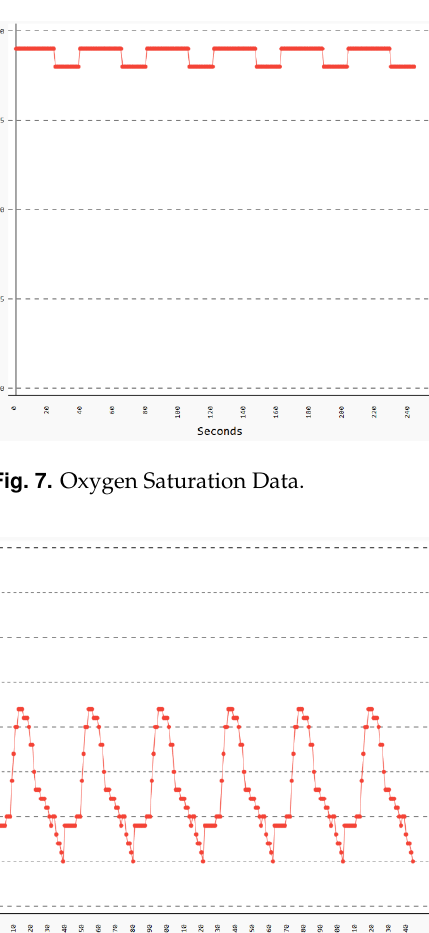
Fig. 6. Block-Time Average in Proposed Systems and Actual Network.